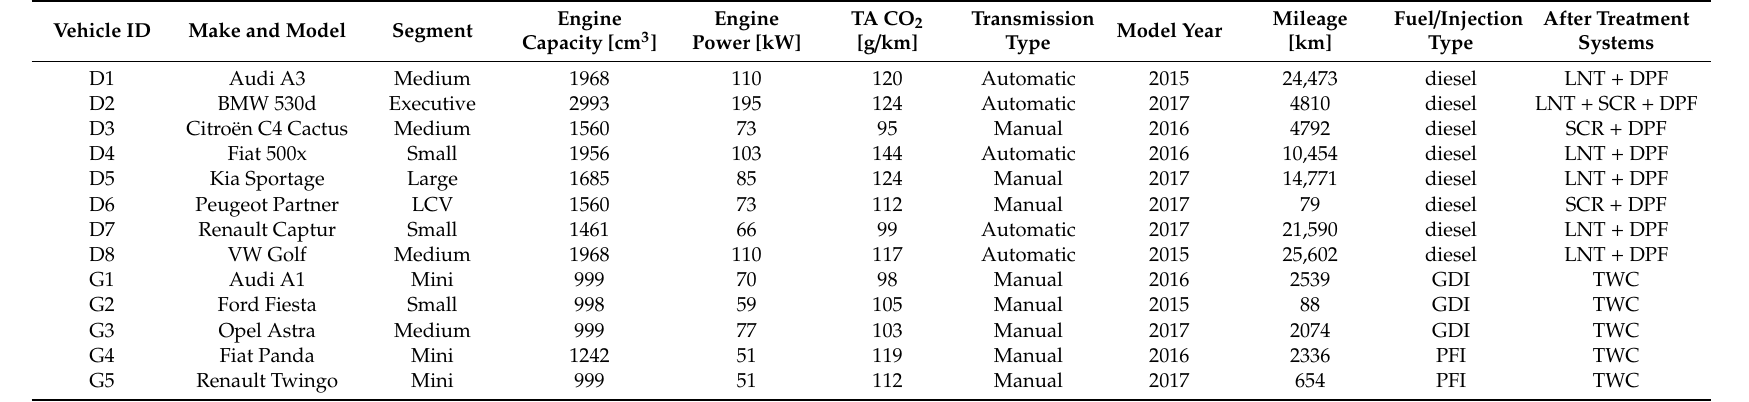
Table 1. Vehicle